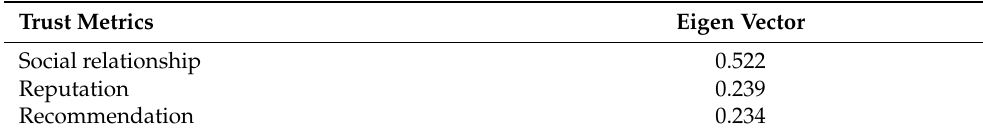
Table 13. Eigenvector on trust metrics for scenario